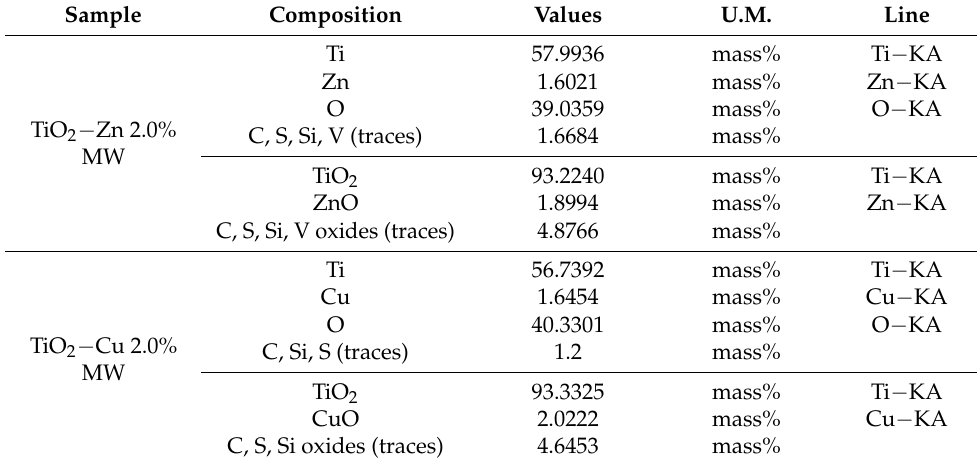
Table 4. Elemental composition of the analyzed